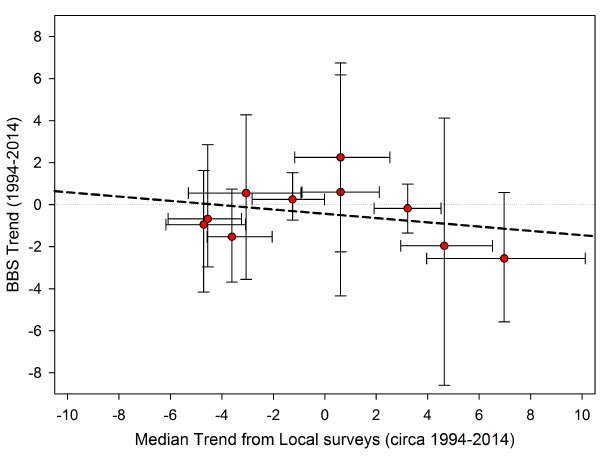
Fig. 2. Comparison between trend estimates derived from revisits to historic (circa 1994) research sites in the boreal mixedwood forests of central Saskatchewan and trends derived from the North American Breeding Bird Survey (1994–2014) for Bird Conservation Region 6 (Boreal Plain ecozone). Error bars denote 95% credible intervals around median trends.